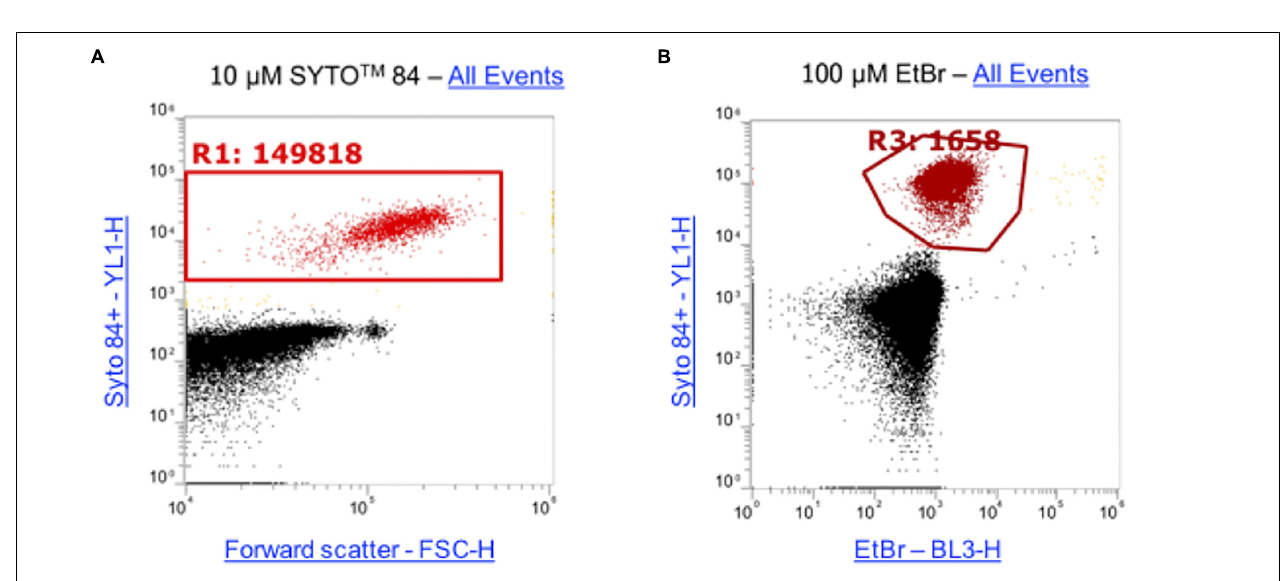
FIGURE 3 | Concentrations of SYTO TM 84 and ethidium bromide used in this assay. (A) 10 µ M SYTO TM 84 was used and a population gated (R1) on a orange fluorescence (YL1-H) versus forward scatter (FSC-H) dot plot to identify SYTO TM 84 fluorescence. The concentration was used as it gave the best separation of cells (red) from background cell debris and other particulate noise (black). (B) 100 µ M was the optimum concentration of ethidium bromide used as shown via a dot plot of YL1-H (SYTO TM 84) vs BL3-H (ethidium bromide). Both plots show all events.